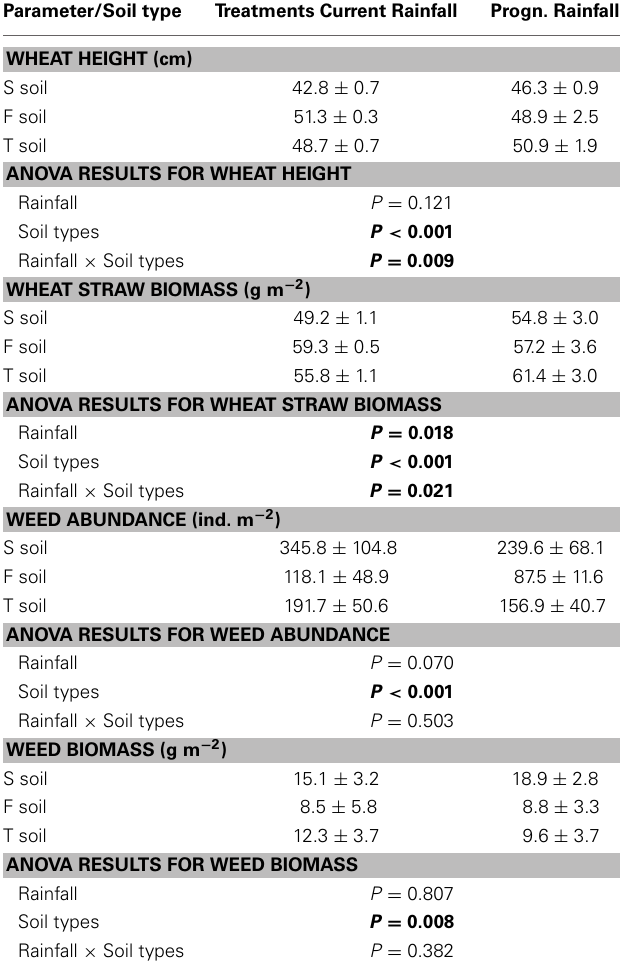
Table 4 | Wheat height, wheat straw mass, weed abundance and biomass (all averaged across several sampling dates) in lysimeters cultivated with wheat in response to current vs. prognosticated rainfall variations and different soil types (S—calcaric phaeozem,